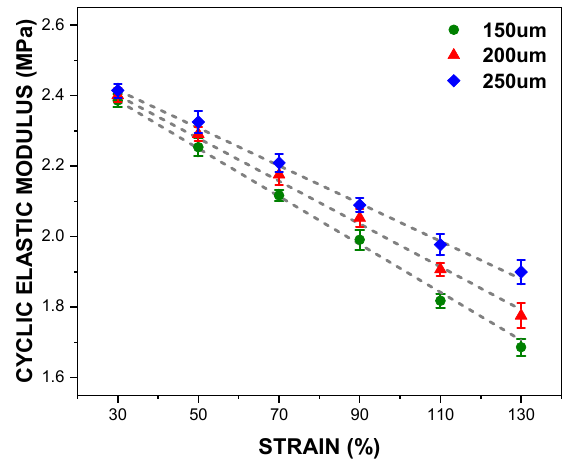
Figure 8. Cyclic elastic modulus against the thickness and the strain. Table 3. Summary of cyclic elastic modulus of the PDMS films. Cyclic Elastic Modulus (MPa) Thickness of the PDMS Films ( µ Strain (%)